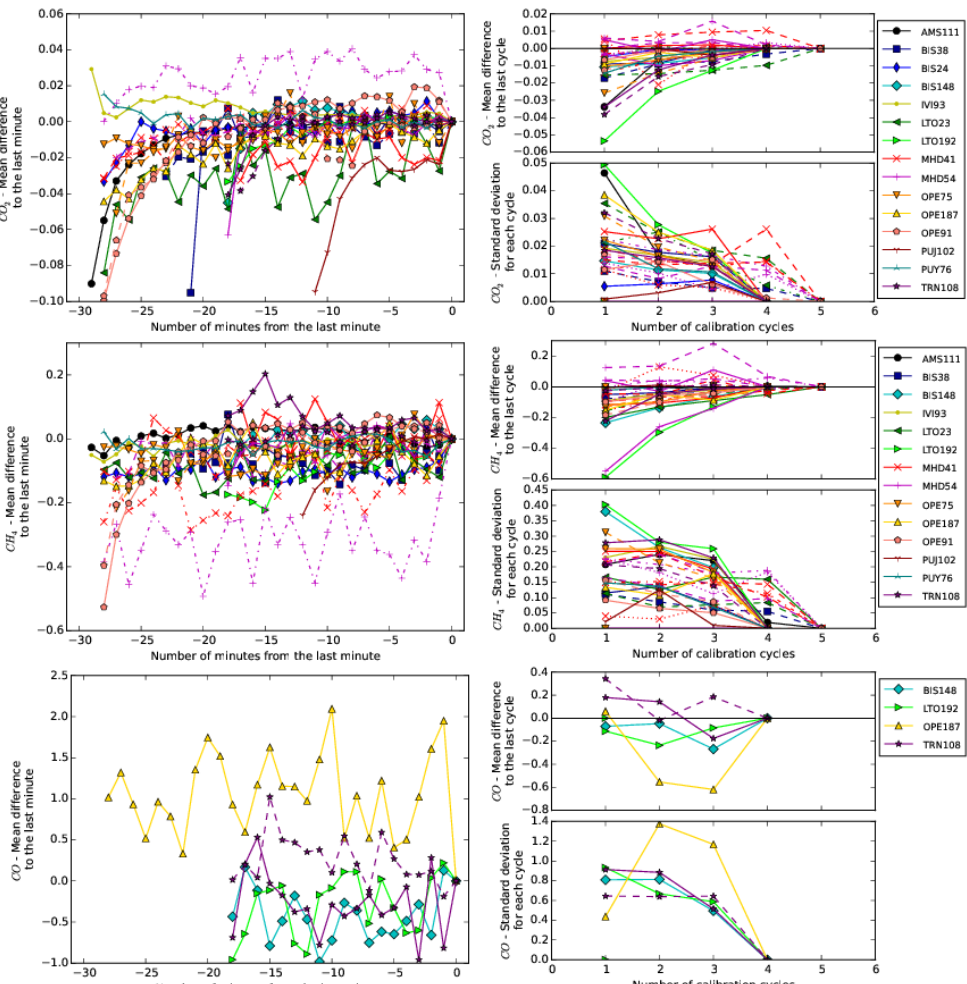
Figure 11. Top: CO 2 (ppm). Middle: CH 4 (ppb). Bottom: CO (ppb). Left: mean difference to the last minute for one measurement interval. Right: mean difference to the last cycle and SD of a calibration sequence. Dashed, dotted or dash-dotted lines show a different set of calibration cylinders for a same